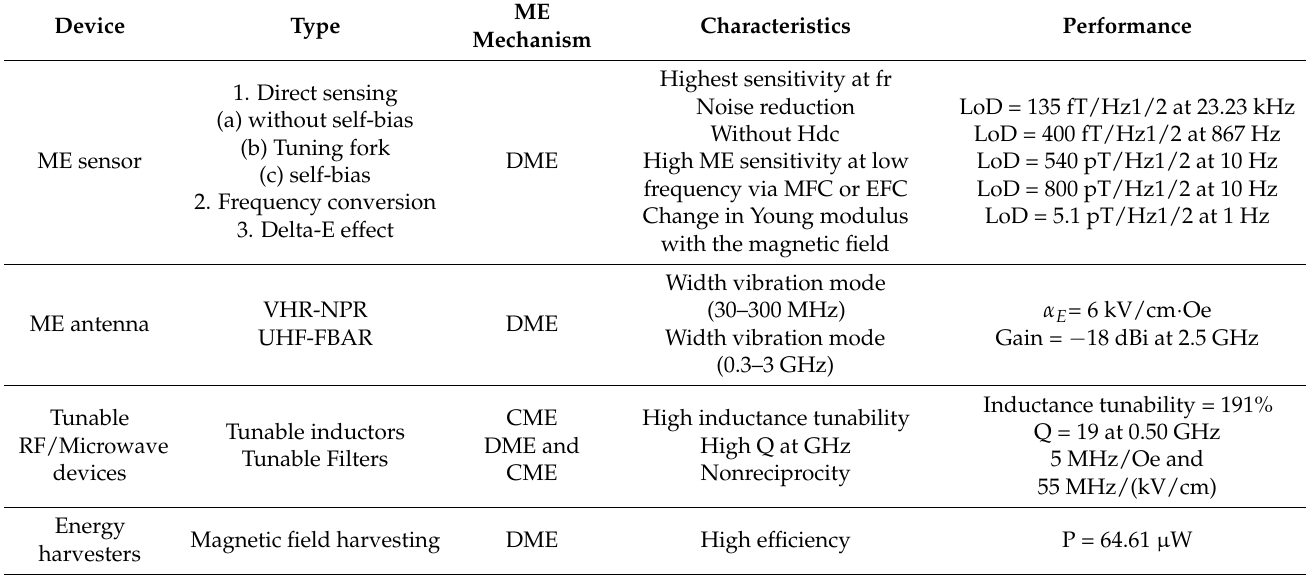
Table 1. Summary of some of the ME devices and their